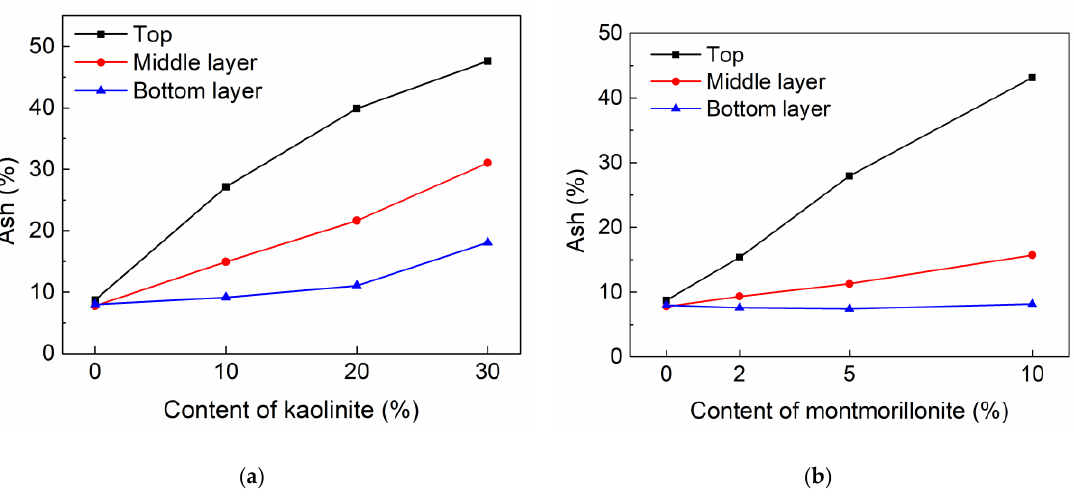
Figure 7. Ash in different parts of filter cakes for cases with different contents of ( a ) kaolinite and ( b ) montmorillonite.